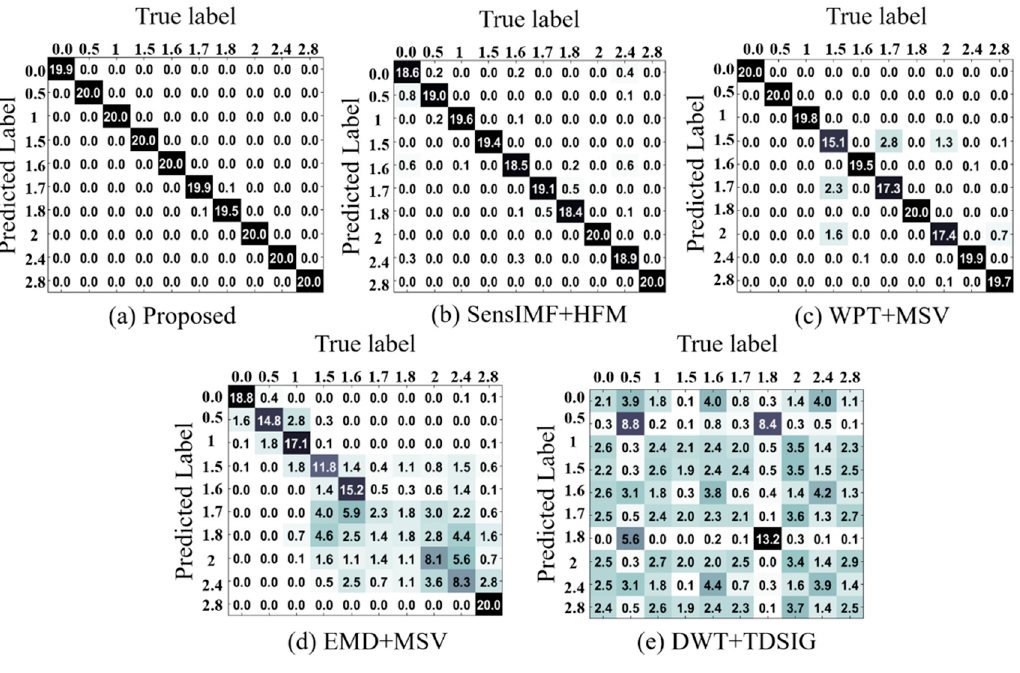
Figure 9. Confusion matrices for classification using ( a ) proposed; ( b ) SensIMF + HFM [30]; ( c ) WPT + MSV [4]; ( d ) EMD + MSV [24]; and ( e ) DWT + TDSIG [5] approaches. All results are presented as the average of 20 experiments.